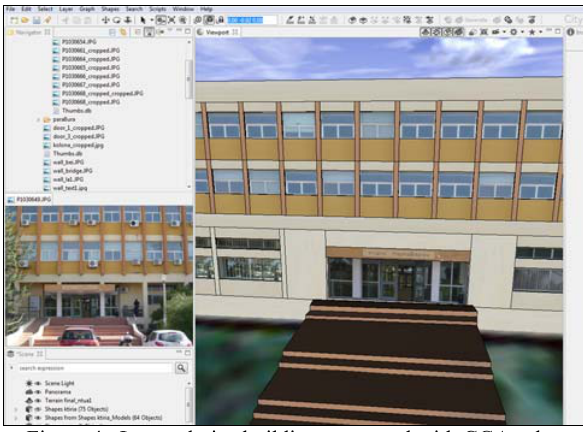
Figure 4. Lampadarios building generated with CGA rules